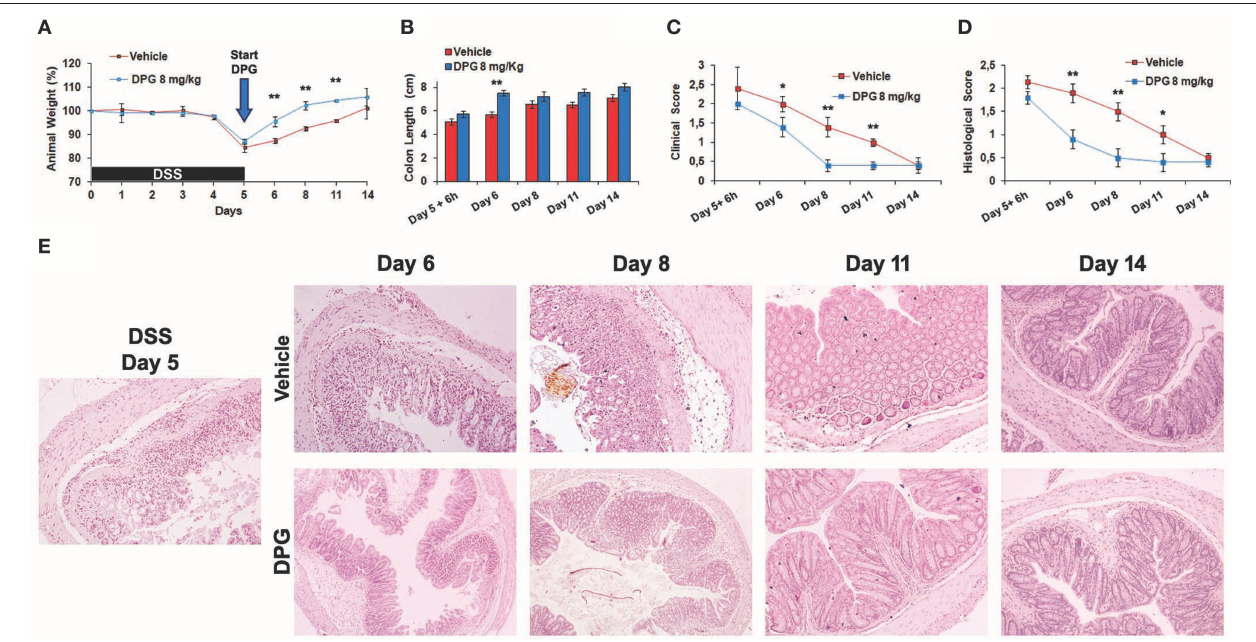
FIGURE 4 | DPG accelerates mucosal healing during recovery phase of DSS-induced acute colitis. C57BL/6 mice were treated with 3% DSS for 5 days and then were untreated or treated with DPG (8 mg/kg) for successive 9 days. Following parameters were analyzed: (A) weight loss; (B) colon length; (C) clinical score (stool consistency, presence of blood in stool and general appearance); (D) histological score; (E) morphology of the colon evaluated through histological analysis (40x magnification in the image) . Five animals per experimental group were used. Statistical analysis: Kruskal-Wallis Test with Dunn’s Multiple Comparisons post-Test . * p < 0.05, ** p < 0.01. UN, untreated animals; DSS, dextran sulfate sodium; DPG, dipotassium